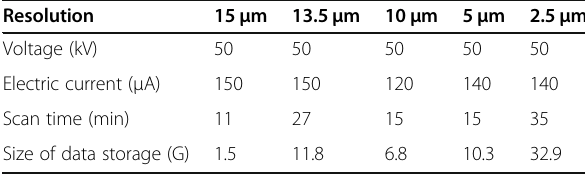
Table 1 Related parameters employed in X-ray